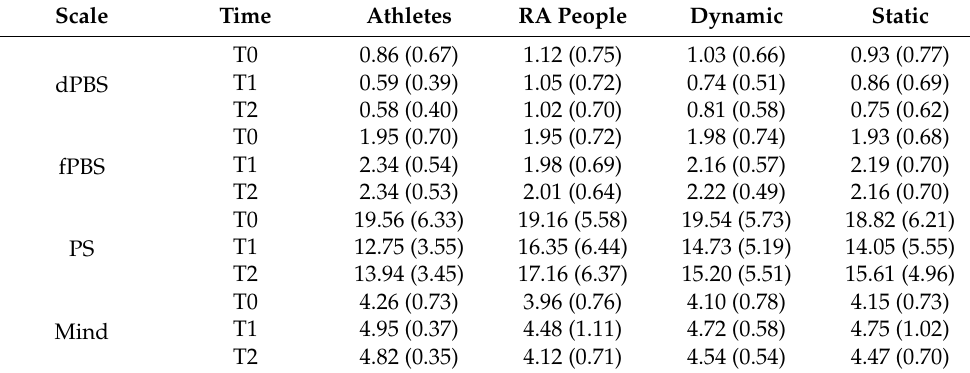
Table 2. Means and standard deviations of psychobiosocial states, Italian perceived stress, and mindful attention awareness scales before intervention, after intervention and follow-up by type of strategy and